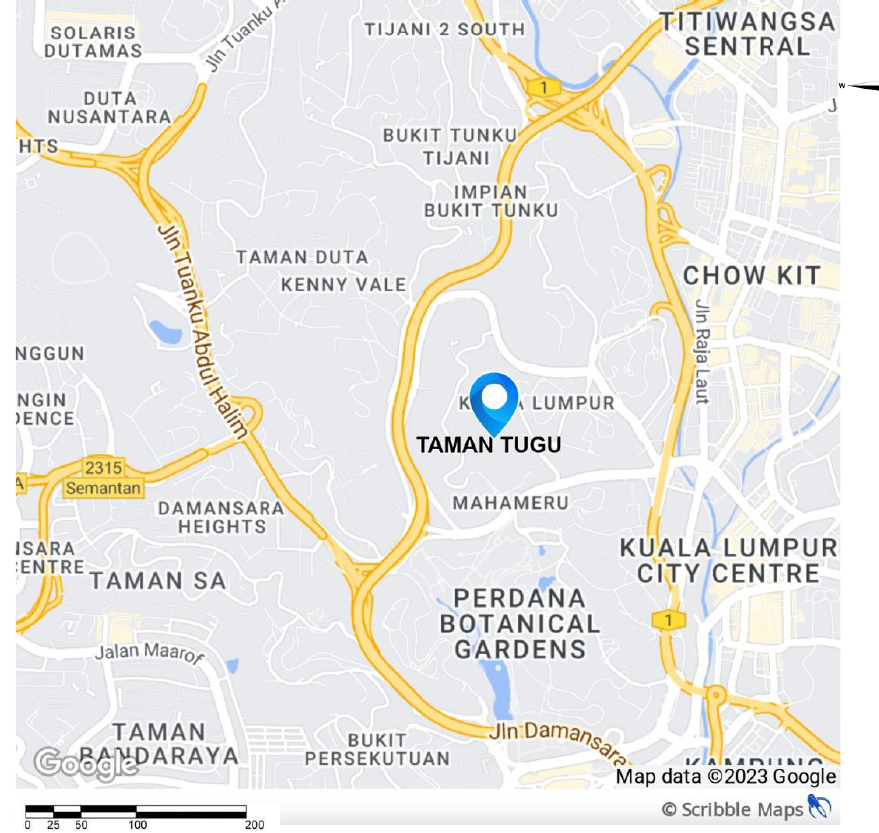
Figure 1. Location of Taman Tugu, Kuala Lumpur.